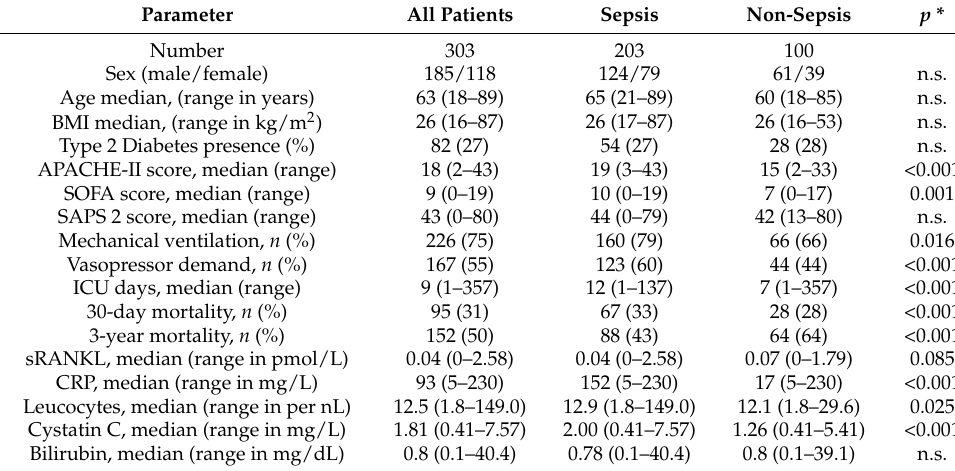
Table 2. Disease etiology of the study population leading to ICU admission.